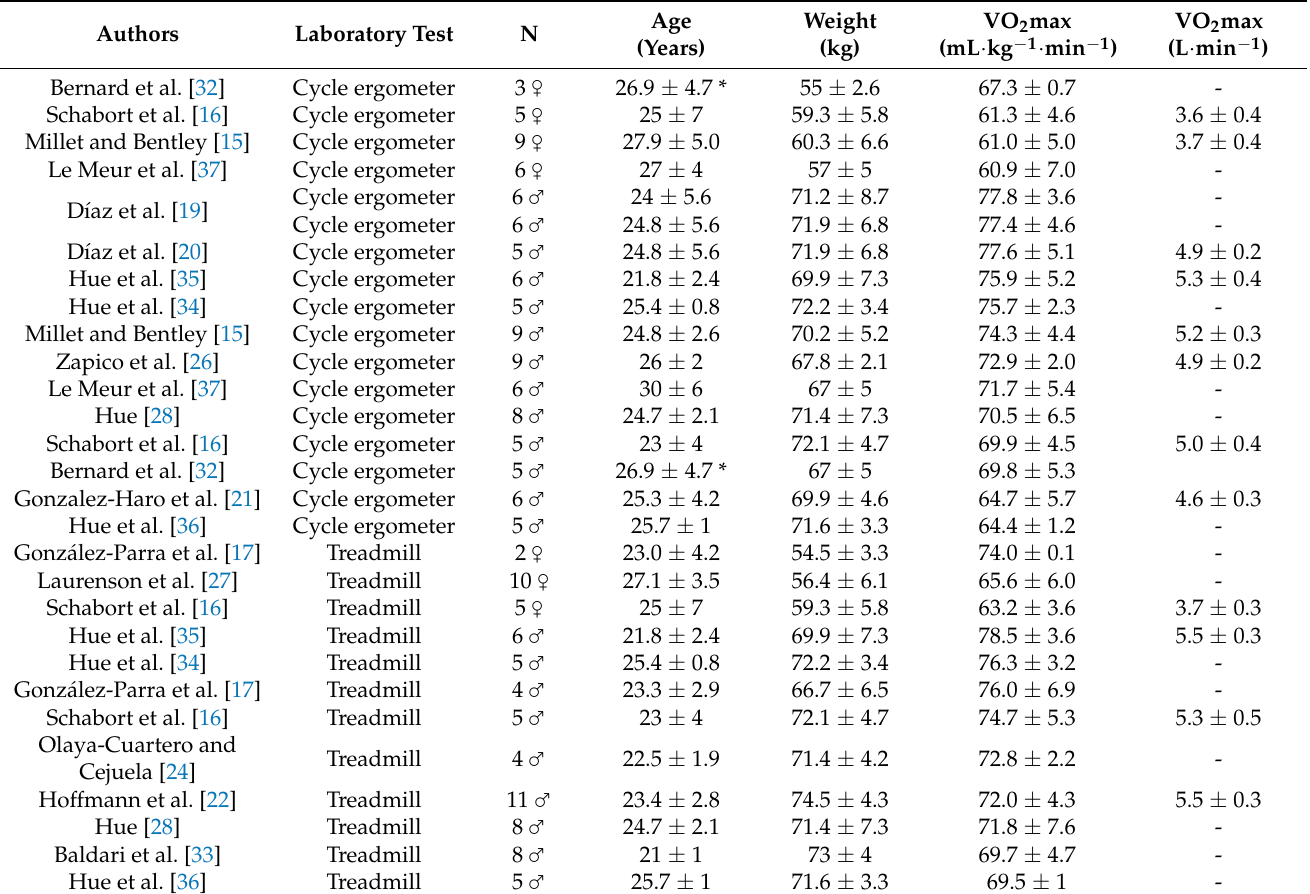
Table 3. Mean ± SD values of VO 2 max reported for elite